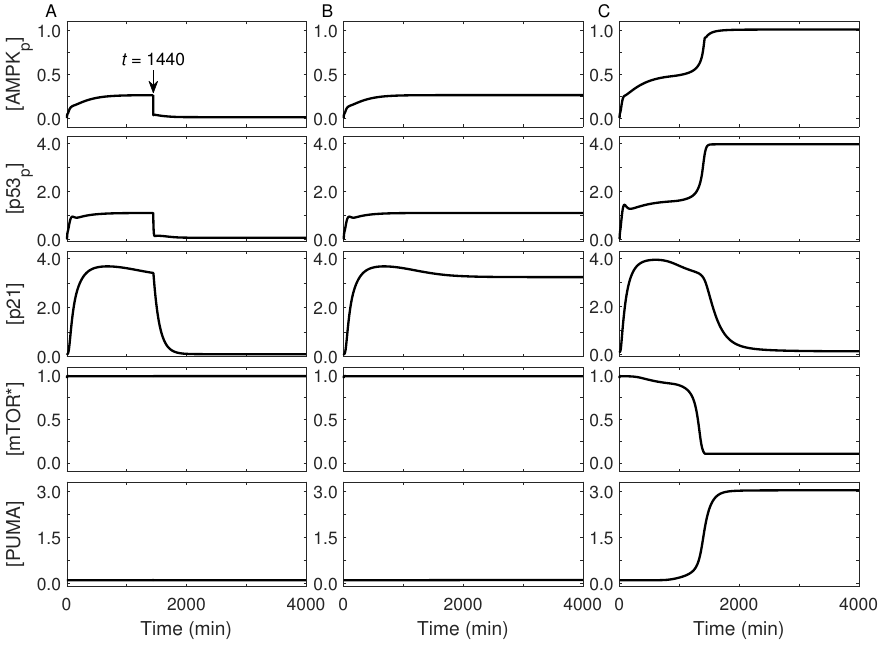
Figure 3. Dynamics of key proteins under typical stress conditions. Shown are time courses of the Figure 3. 3 levels of AMPK p , p53 p , p21, mTOR*, and PUMA (from top to bottom). ( A ) C g equals 0.2 mM during the initial 1440 min and 5 mM thereafter. C g always equals 0.2 mM ( B ) or 0.08 mM ( C ). The arrow in panel ( A ) indicates the timing when the glucose level is restored to 5 p53 p